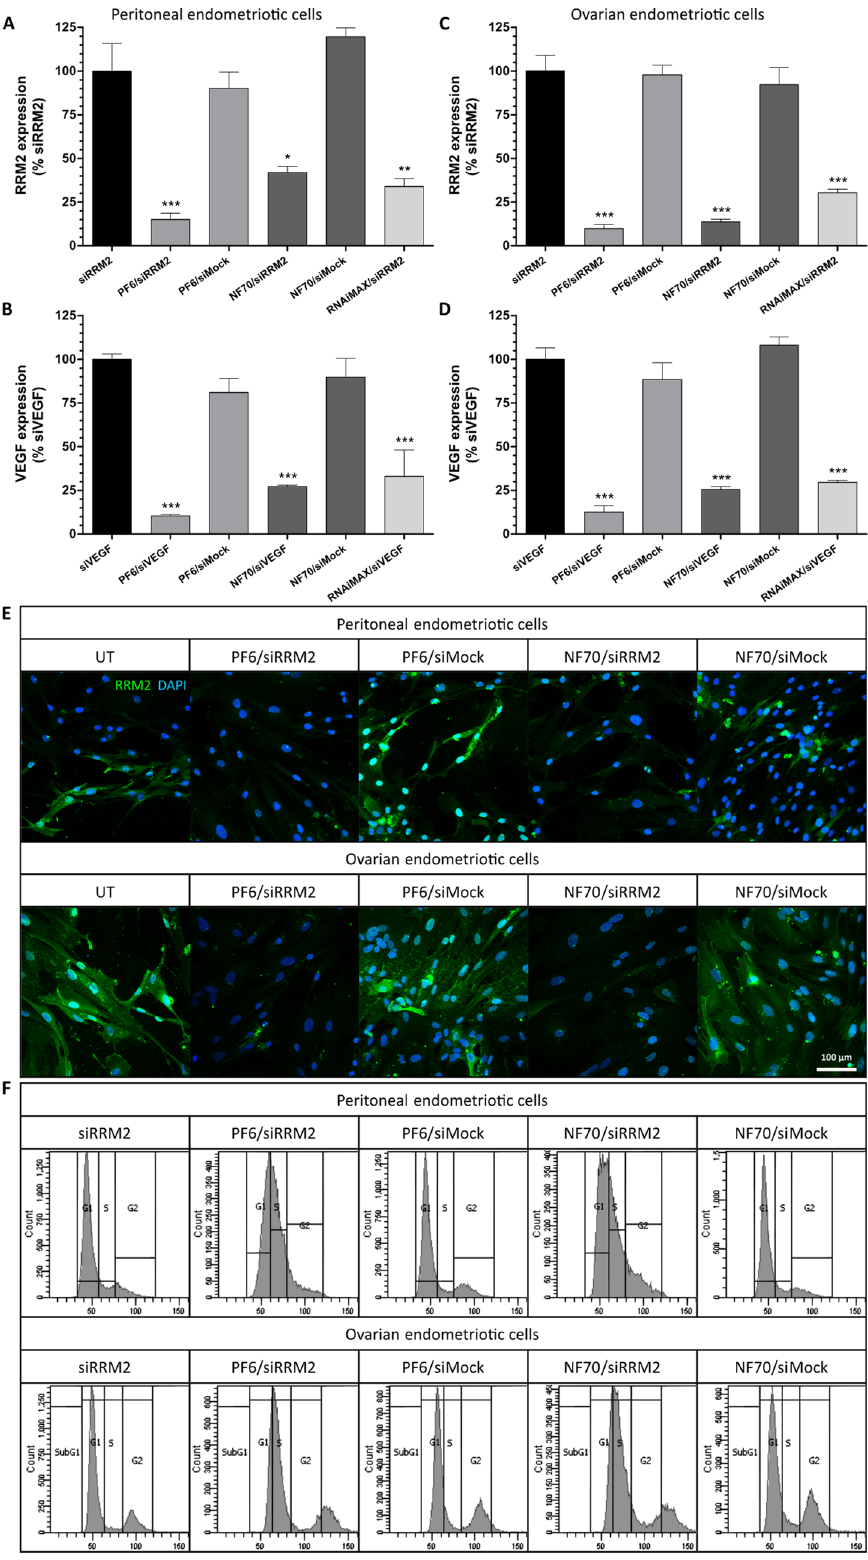
Figure 2. CPP/siRNA NPs induced therapeutic gene knockdown, RRM2 protein decrease, and cell cycle arrest in endometriotic cells. ( A , B ) RRM2 and ( C , D ) VEGF gene expression levels measured in ( A , C ) peritoneal and ( B , D ) ovarian endometriotic cells using qRT-PCR. Data were analyzed by 2 −ΔΔ CT method using GAPDH as an internal control and normalized to relevant pure siRNA groups. Error bars represent SEM of n = 7–8 individual samples from independent experiments. * p < 0.05, ** p < 0.01, *** p < 0.001, one-way ANOVA, Tukey post hoc . ( E ) Representative immunocytochemical